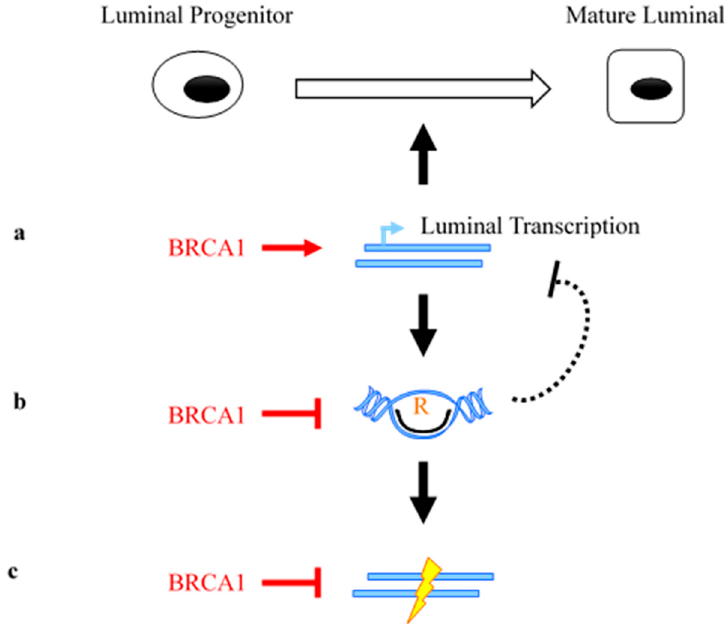
Figure 3. Model depicting BRCA1-dependent transcriptional regulation in tissue-specific tumor suppression. ( a ) BRCA1 is required for luminal differentiation. ( b ) BRCA1 prevents R-loop accumulation in the luminal lineage. ( c ) BRCA1 repairs double-strand breaks.